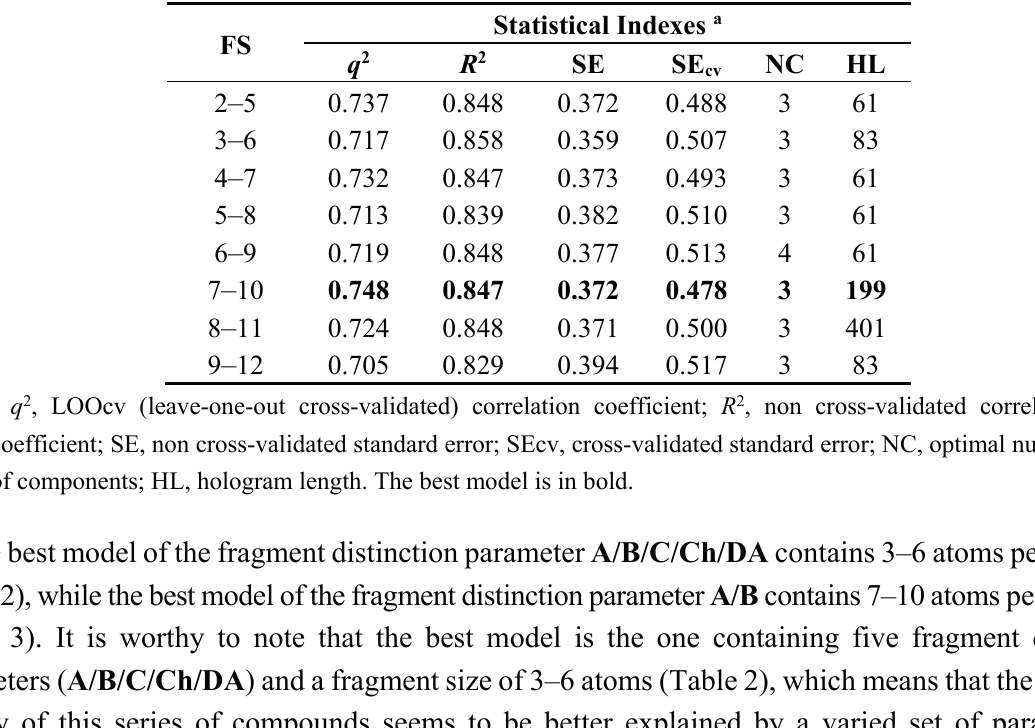
Table 3. Summary of the HQSAR statistical indexes for the influence of various fragment sizes (FS, 2–12 atoms) using the fragment distinction parameter A/B for